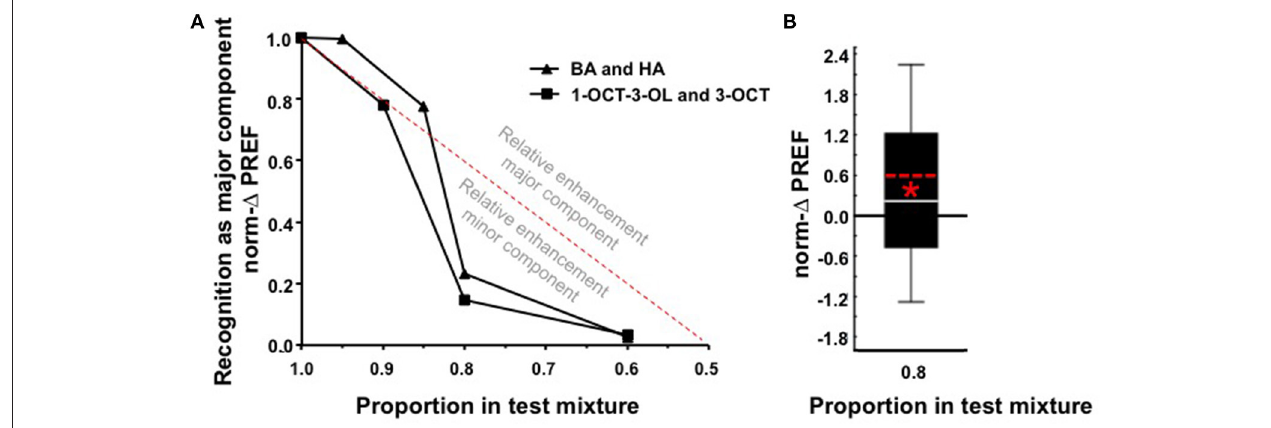
FIGURE 3 | (A) Medians of the norm- 1 PREF scores from Figures 1C , 2C , plotted against the mixture ratio. This illustrates that the impact of the major component is less than one would expect if it were linearly based on the proportion of the mixture components (red stippled line: Y = 2X + [ − 1]). In other words, scores above the red stippled line indicate an enhanced impact of the major component, whereas scores below the red stippled line indicate enhancement of the impact of the minor component, relative to such a linear expectation. A test across the complete dataset represented here by the medians reveals that scores are consistently smaller than this expectation ( W -test, P < 0.05, N = 312) (for the 1.0 case the median norm- 1 PREF score equals 1 by definition, such that they cannot be included in this analysis). Please note that, because for the 0.5 case we used an arbitrary convention as to whether the norm- 1 PREF scores were positive or negative (see Materials and Methods section), the respective points of the functions had to be omitted from this plot. (B) Pooled norm- 1 PREF scores for both odor pairs statistically tested against the linear expectation (i.e., norm- 1 PREF = 0.6, red stippled line) for a mixture with a 0.8 proportion of the major component. * P < 0.05 in a W -test, N =